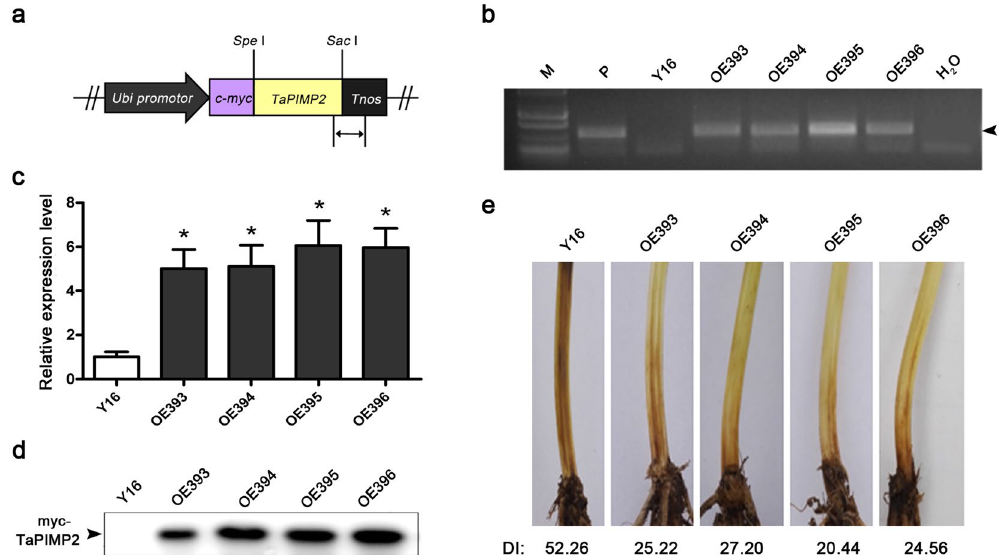
Figure 7. Molecular characterization of TaPIMP2-overexpression wheat plants and responses to Bipolaris sorokiniana . ( a ) Scheme of the TaPIMP2 expression cassette on the transformation vector pUBI::myc-TaPIMP2. Ubi : maize ubiquitin promoter; Tnos : terminator of Agrobacterium tumefaciens nopaline synthase gene. The arrow indicates the amplified regions of transgenic plants by PCR. ( b ) PCR patterns of the TaPIMP2 - transgenic wheat lines using the primers specific to the TaPIMP2-Tnos cassette. M: molecular marker; P: plasmid pUBI::myc-TaPIMP2; Y16: the recipient Yangmai 16. ( c ) Relative expression levels of TaPIMP2 in overexpressing wheat lines and untransformed Yangmai 16. The relative transcript level in the untransformed Yangmai 16 was set to 1. ( d ) Western blotting analysis of the TaPIMP2-overexpressing wheat lines and untransformed Yangmai 16 using an anti-myc antibody. ( e ) The typical common root rot symptoms of TaPIMP2-overexpression and untransformed Yangmai 16. Values represent the mean and standard deviation from three independent biological replicates (Student’s t - test : * P <